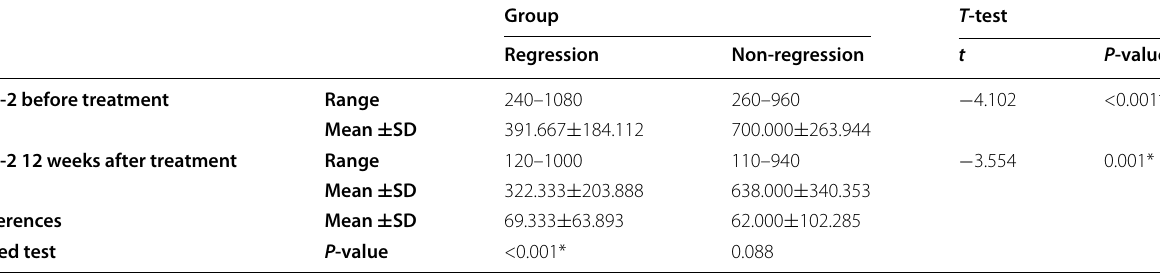
Table 10 Comparison between pretreatment and 12 weeks after EOT Angiopoietin-2 levels in patients with and without fibrosis regression